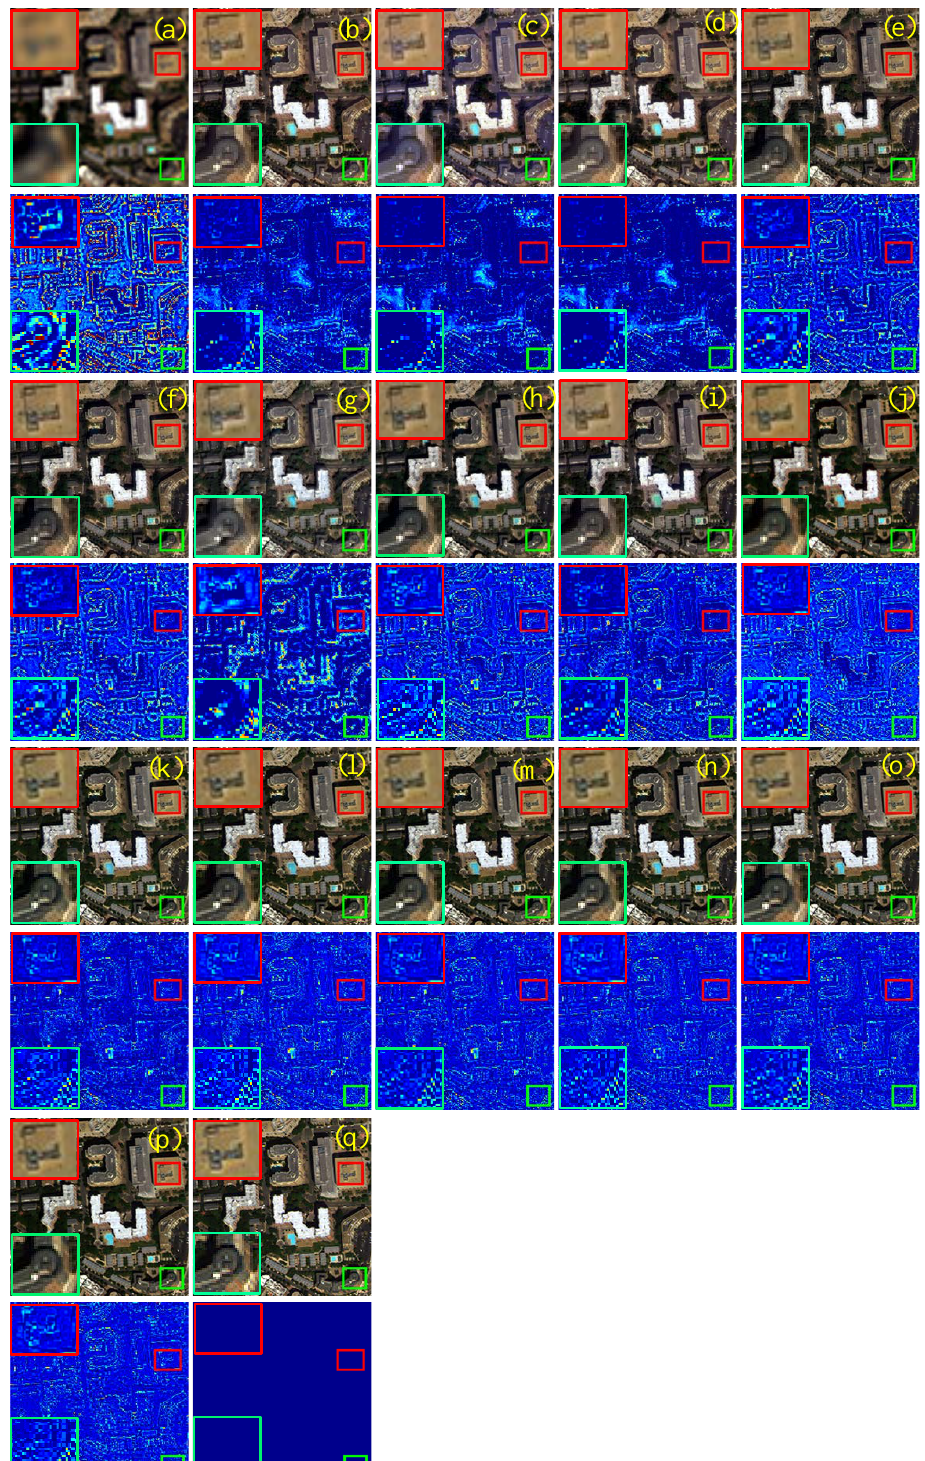
Figure 5. Visualization of image sharpening results in reduced resolution. The input LRMS and PAN images from the WorldView-2 dataset with sizes of 256 × 256 and 1024 × 1024, respectively. The enlarged red box view is located in the upper left corner. ( a ) EXP; ( b ) PCA; ( c ) IHS; ( d ) GS; ( e ) HPF; ( f ) SFIM; ( g ) Indusion; ( h ) FE-HPM; ( i ) PWMBF; ( j ) PNN; ( k ) DRPNN; ( l ) PercepPan; ( m ) PGMAN; ( n ) BAM; ( o ) MC-JAFN; ( p ) Our; ( q )